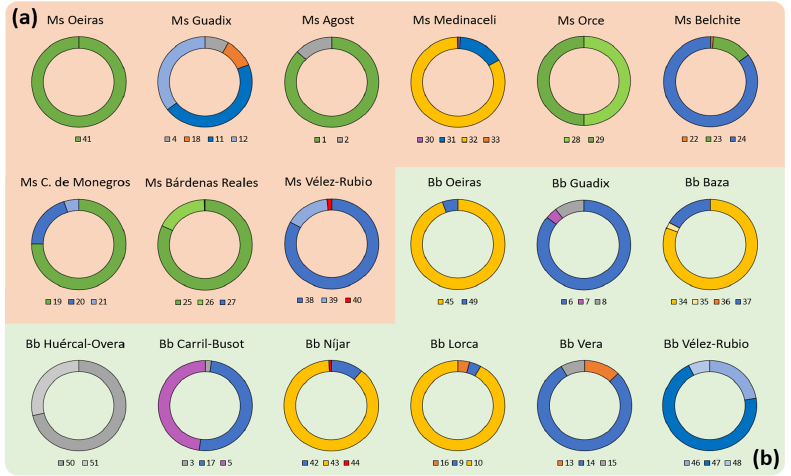
Figure 5. Population distribution in communities isolated from Medicago sativa and Bituminaria bituminosa seeds. The circle pie charts show the proportion of each strain isolated by sample location in ( a ) Medicago sativa (orange-background group) and ( b ) Bituminaria bituminosa (green-background group) seeds. Colors of each section represent Stenotrophomonas maltophilia (blue), Paenibacillus polymyxa (green), other Paenibacillus strains (yellow), Enterobacteriaceae strains (orange), Bacillaceae strains (purple), putative pathogens Erwinia sp. and Kosakonia cowanii (red), and unidentified strains (grey). If two or more strains identified in same sample belong to the same species, the range of intensity of the color (light to dark) is included, with a darker tone representing a larger proportion compared to the total population. Data shown is representative of three independent experiments (n = 6).